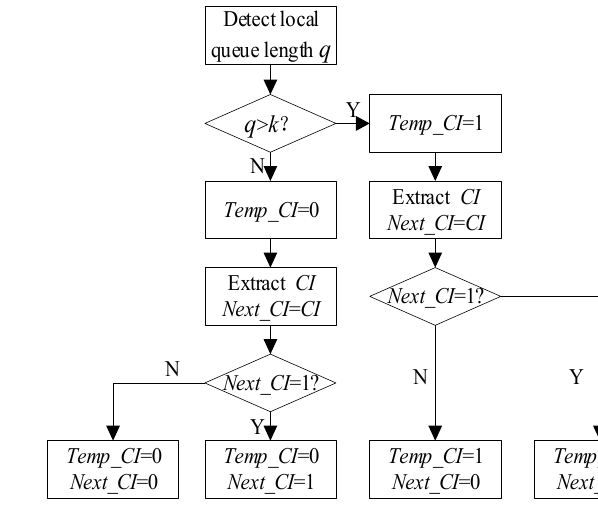
Figure 5. Classification of congestion conditions. Algorithm 1 : Pseudo code for the congestion condition transmission